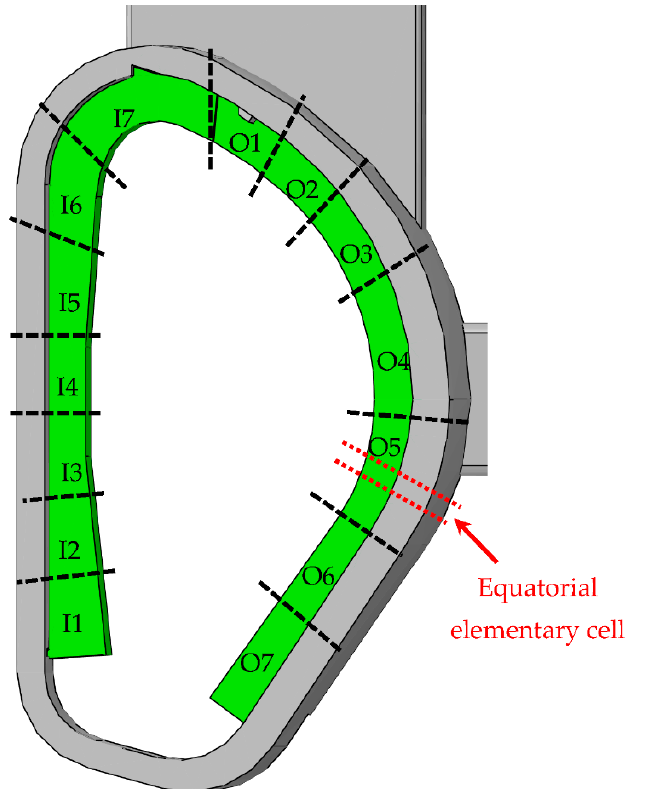
Figure 1. Poloidal Segmentation of the DEMO BB and numbering of the Inboard and Outboard poloidal regions.